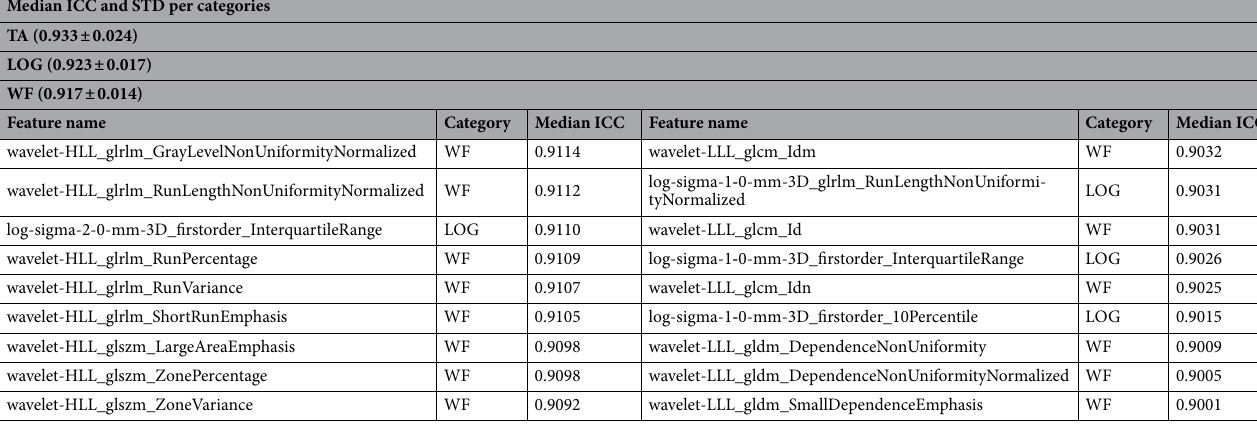
Table 1. Overall summary of the 108 most repeatable and reproducible features for all the experiments and presenting correlations with tumour volume ρ < 0.9. The features are ordered by decreasing median ICC values (computed on all the experiments). Most reproducible and repeatable features per categories were: GLRLM- Non-Uniformity (LOG-2 mm kernel); LLH-GLCM-JointEnergy (WF) and Gray Level Dependence Matrix (GLDM) Non-Uniformity